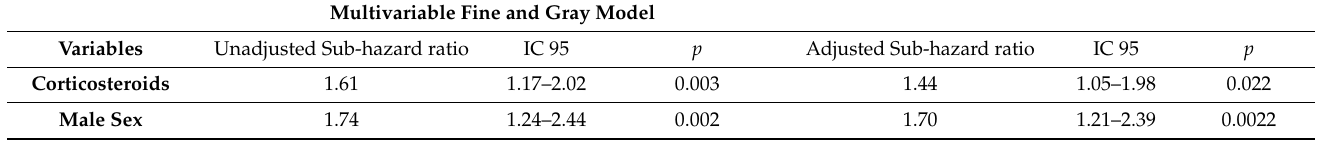
Table 3. Variables associated with a first episode of VA-LRTI in 322 patients with severe COVID-19, using multivariable Fine and Gray models, considering death and extubation as competing events. Adjusted sub-hazard ratios are adjusted for prespecified confounders suspected to be associated with VA-LRTI, including age, immunosuppression, recent antibiotic treatment, and ARDS severity. Multivariable Fine and Gray